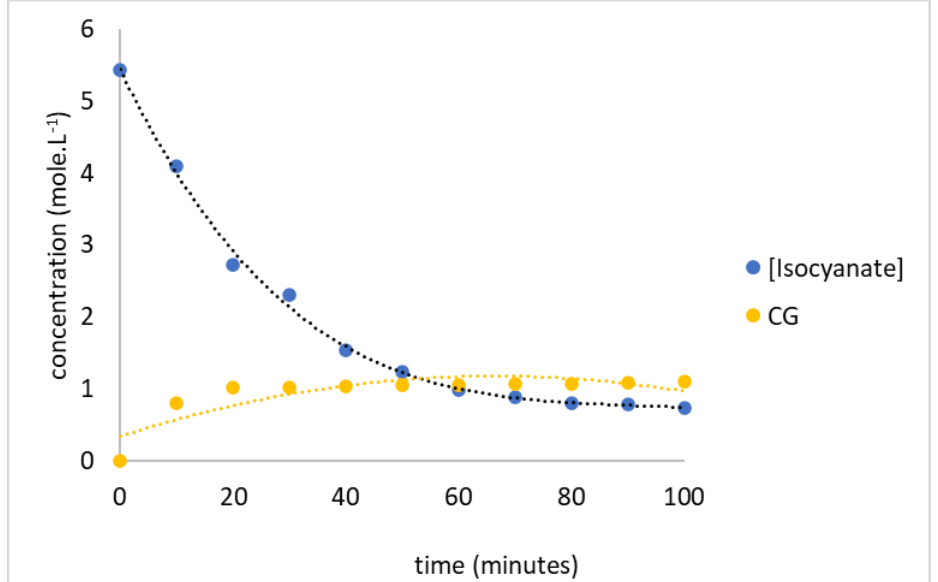
Figure 6. The decreasing isocyanate concentration and increasing diazene oxide concentration following hexogen coating with TDI.